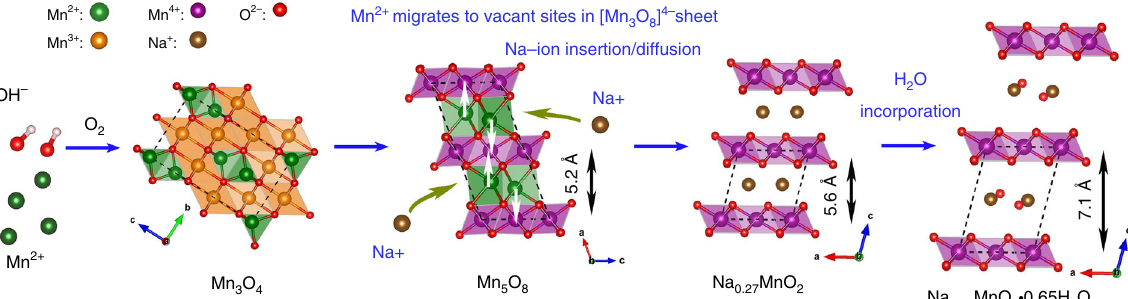
Fig. 3 The schematic of the formation mechanism. The proposed Na-ion driven intercalation in the formation of Na 0.27 MnO 2 ·0.65H 2 O materials in solid- state (Mn 2 + : green; Mn 3 + : orange; Mn 4 + : purple; Na + : brown; O: red)